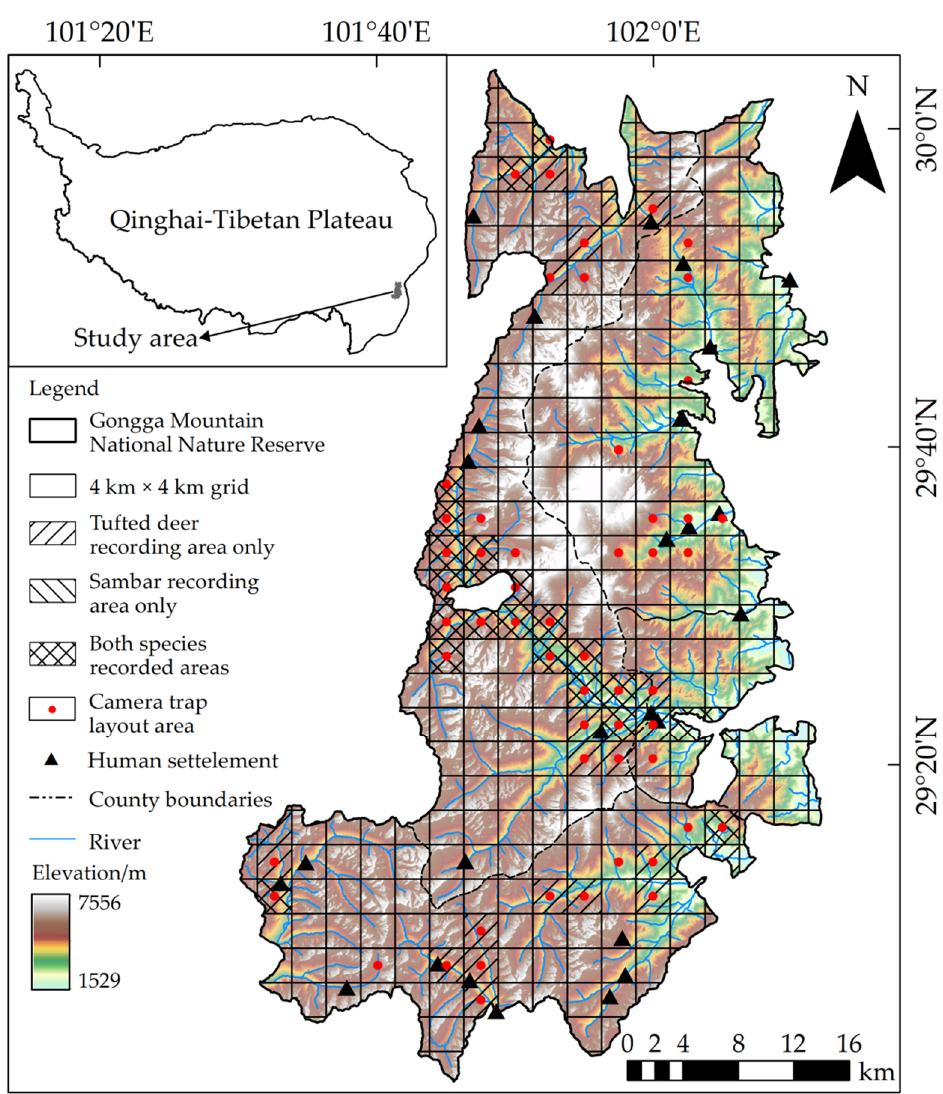
Figure 1. Distribution grid records for tufted deer and sambar recorded in the Gongga Mountain National Nature Reserve, China.